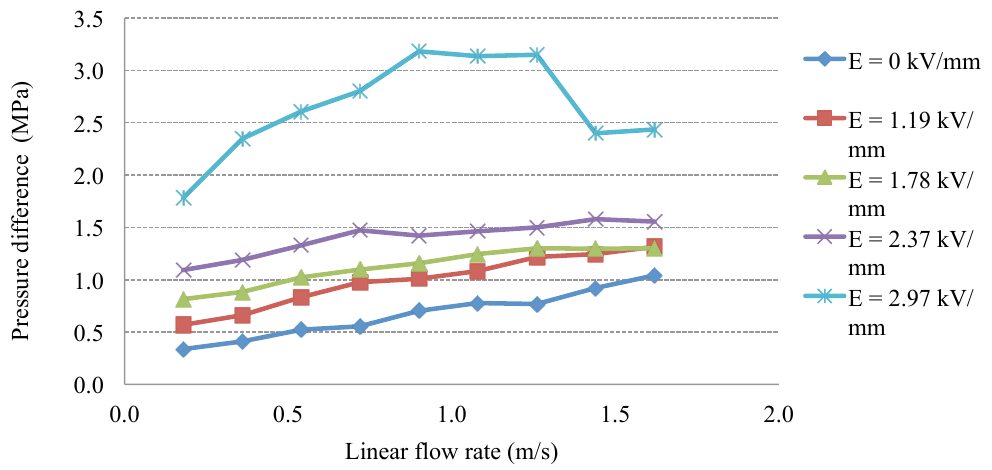
Figure 12. The pressure difference through the ERF valve under various flow velocities and applied E-fields is shown.